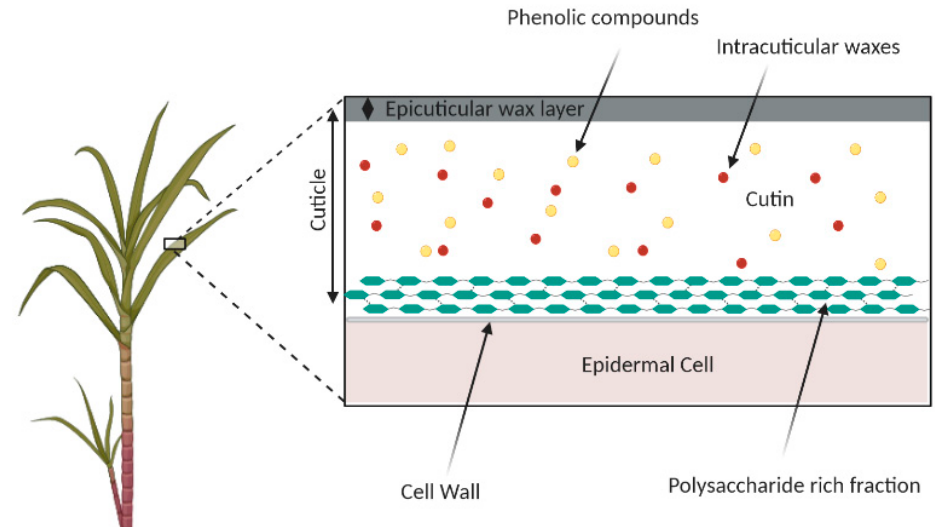
Figure 2. Representation of the cross-section of sugarcane plant cuticle [48].